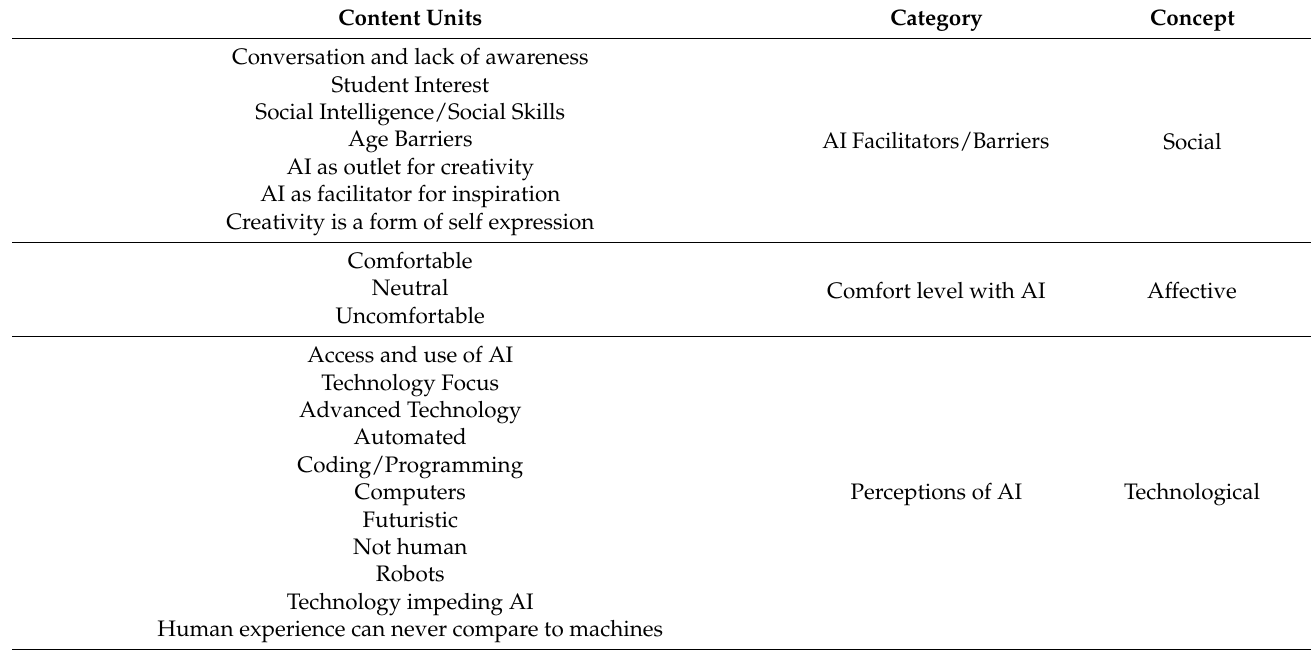
Table A1. Content units, categories and concepts derived from the qualitative data. Content